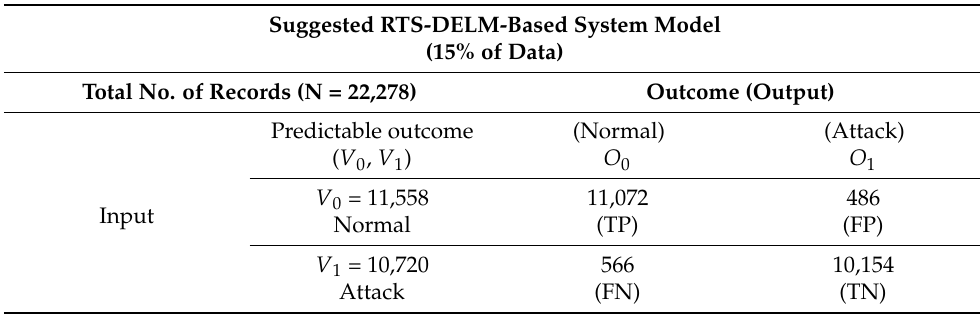
Table 2. Validation of the proposed blockchain-based smart home network architecture for the estimation of intrusion with fused dataset empowered with Fused